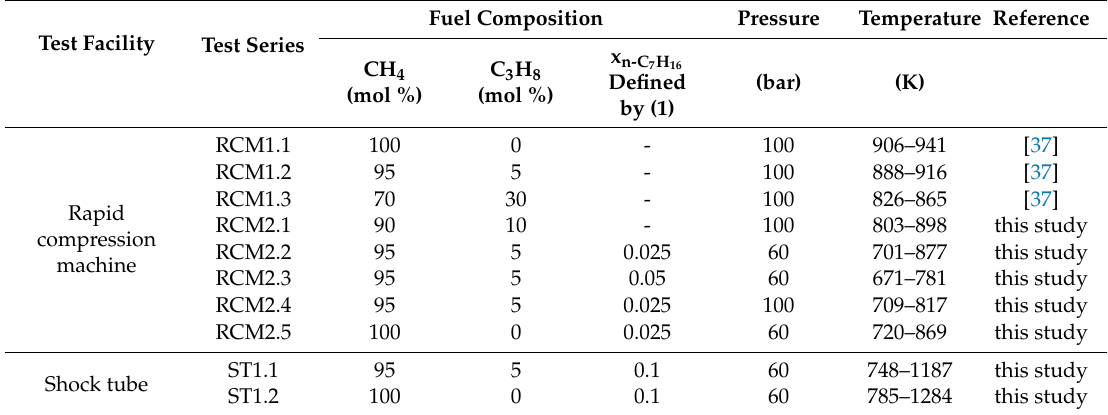
Table 1. Experimental test matrix of ignitability investigations with a rapid compression machine (RCM) and a shock tube